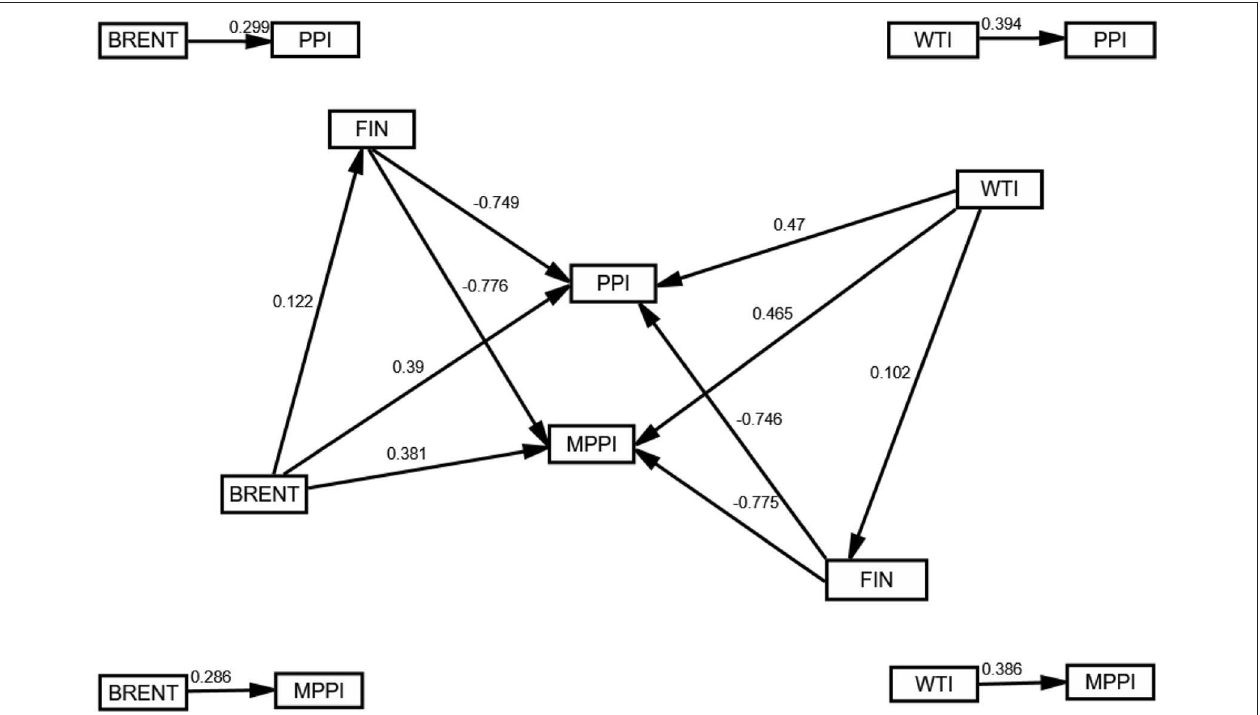
FIGURE 7 | The mediating effect of government debt. The center portion of the figure reports the direct and indirect effects. The areas around the figure show the total effect.